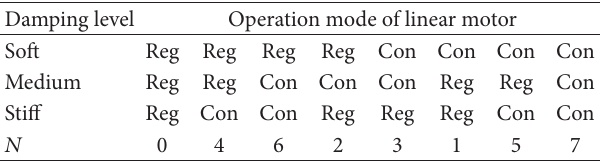
Table 2: Description of the active suspension operation states. Operation state of Damping level active suspension